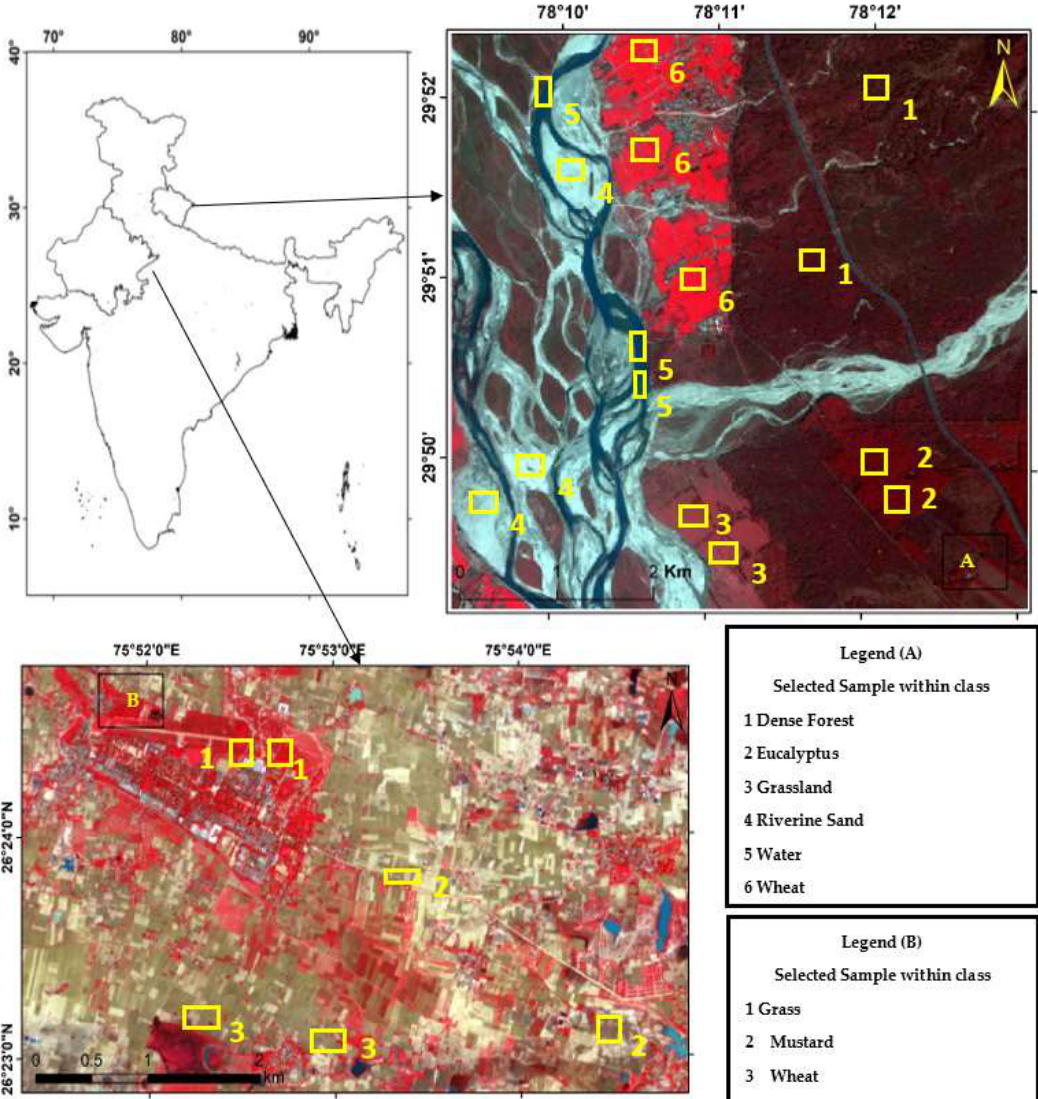
Figure 8. Study Areas ( A ) Haridwar (Uttarakhand) ( B ) Banasthali (Rajasthan).